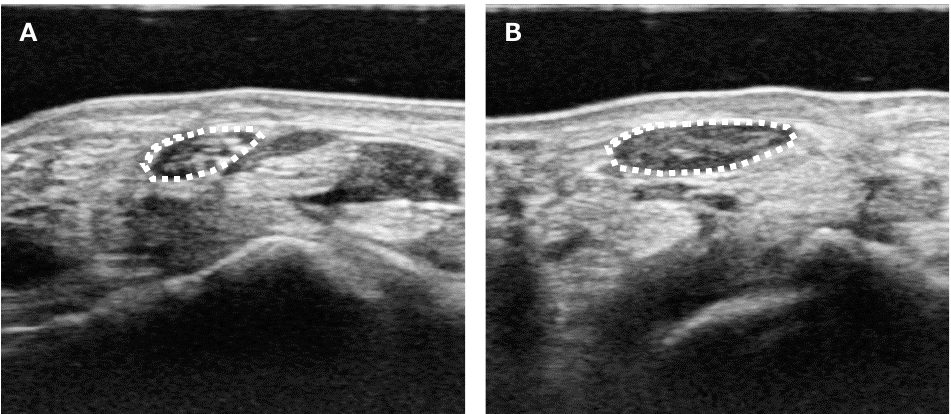
Figure 1. Ultrasound measurement of the median nerve CSA. ( A ) Unaffected side. ( B ) Affected side. CSA was measured as the only parameter for the image analysis. Median nerve CSA was measured at the wrist crease level. The median nerve was outlined (white dotted line), and its area was calcu- lated.